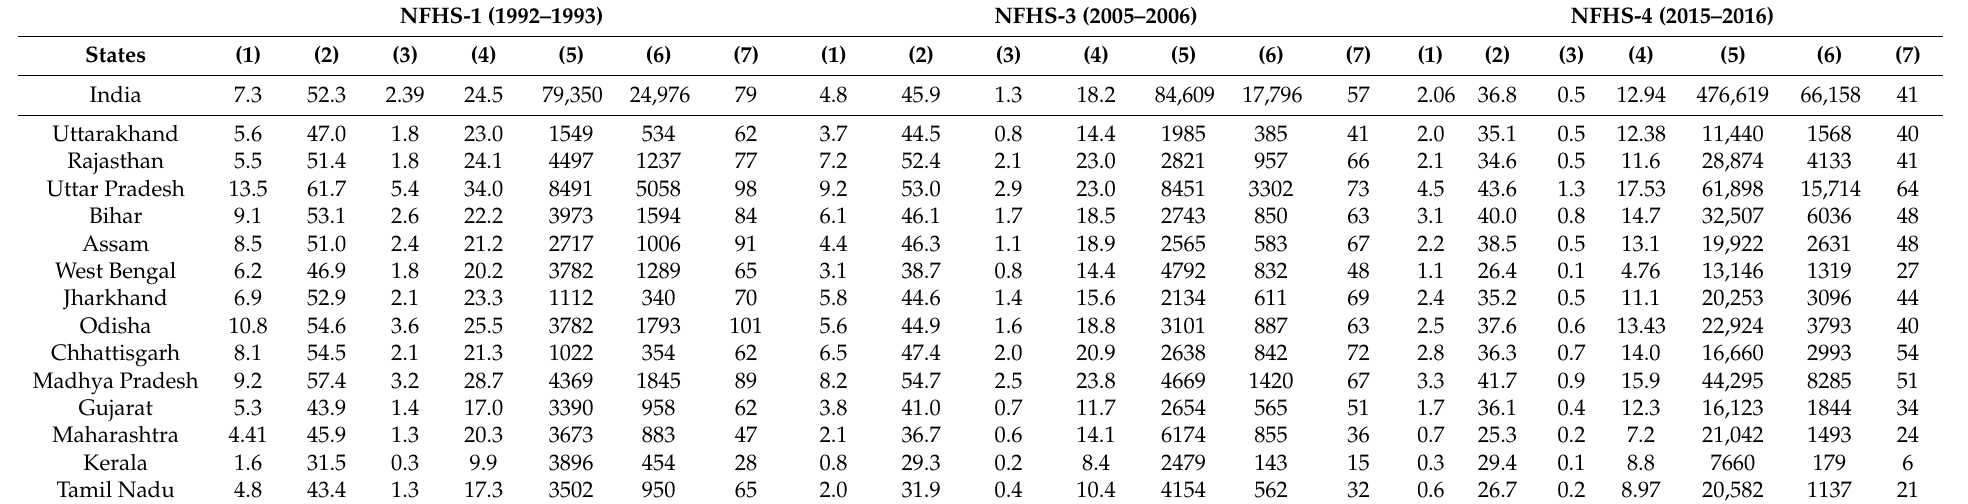
Table 1. Levels of clustering of infant deaths in families in India and its selected states,